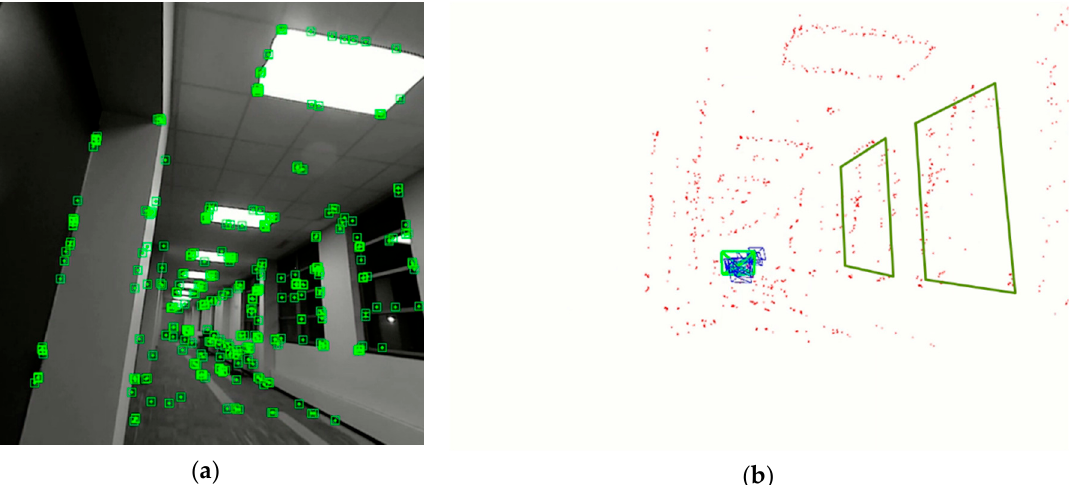
Figure 3. Reconstruction and registration of macro-features in 3D from ( a ) tracked features to ( b ) the generated Simultaneous Localization and Mapping (SLAM) map showing the 3D reconstructed windows and previously registered keyframes in blue quads.